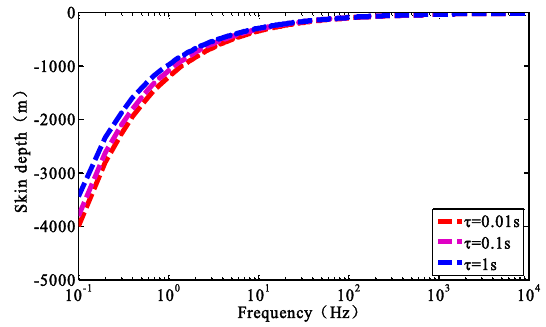
Figure 7. Generalized skin depth curves with different characteristic time constants.